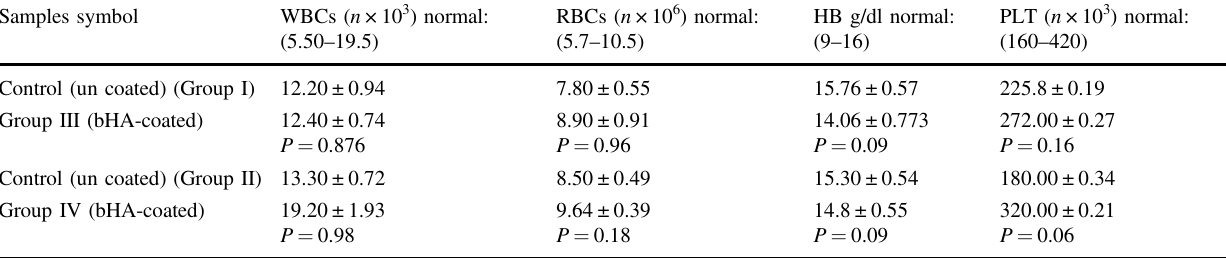
Table 4 Toxicity effects on RBCs, WBCs, hemoglobin, and PLT count at 45 days post surgery Samples symbol